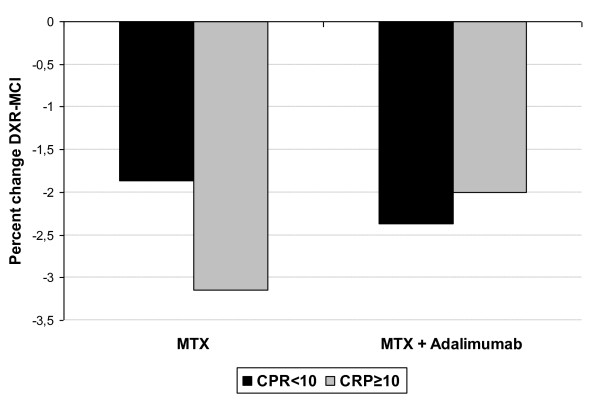
DXR-MCI loss in the methotrexate (MTX) plus adalimumab and MTX groups according to CRP level achieved.